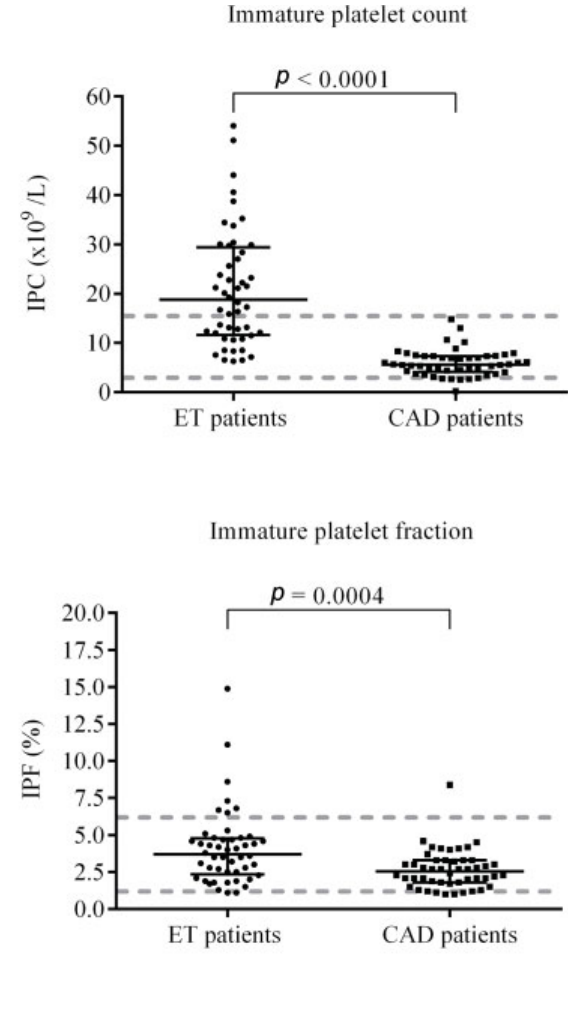
Fig. 2 Comparison of immature platelet count (IPC) and immature platelet fraction (IPF) in 48 patients with essential thrombocythemia (ET) and 48 patients with coronary artery disease